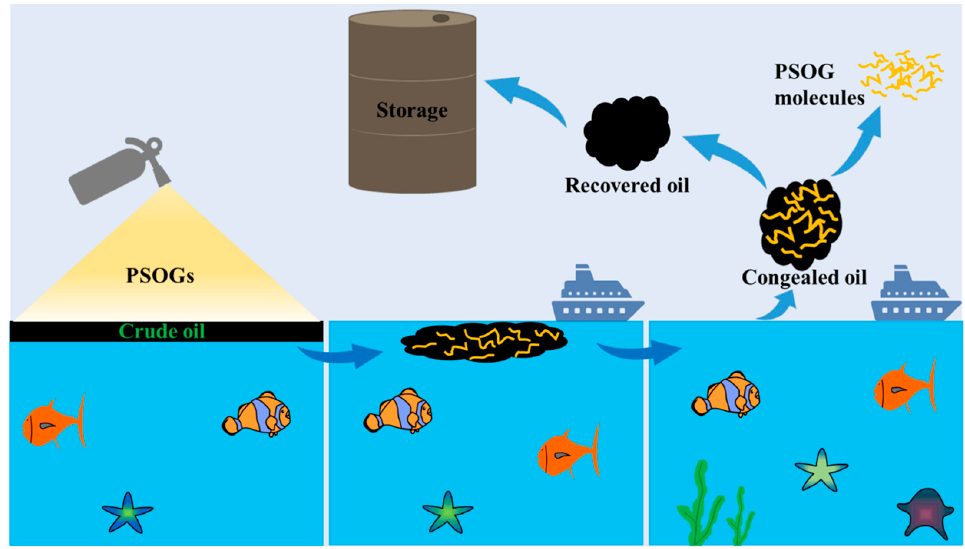
Figure 1. Potential application of PSOGs in oil spill response and recovery.